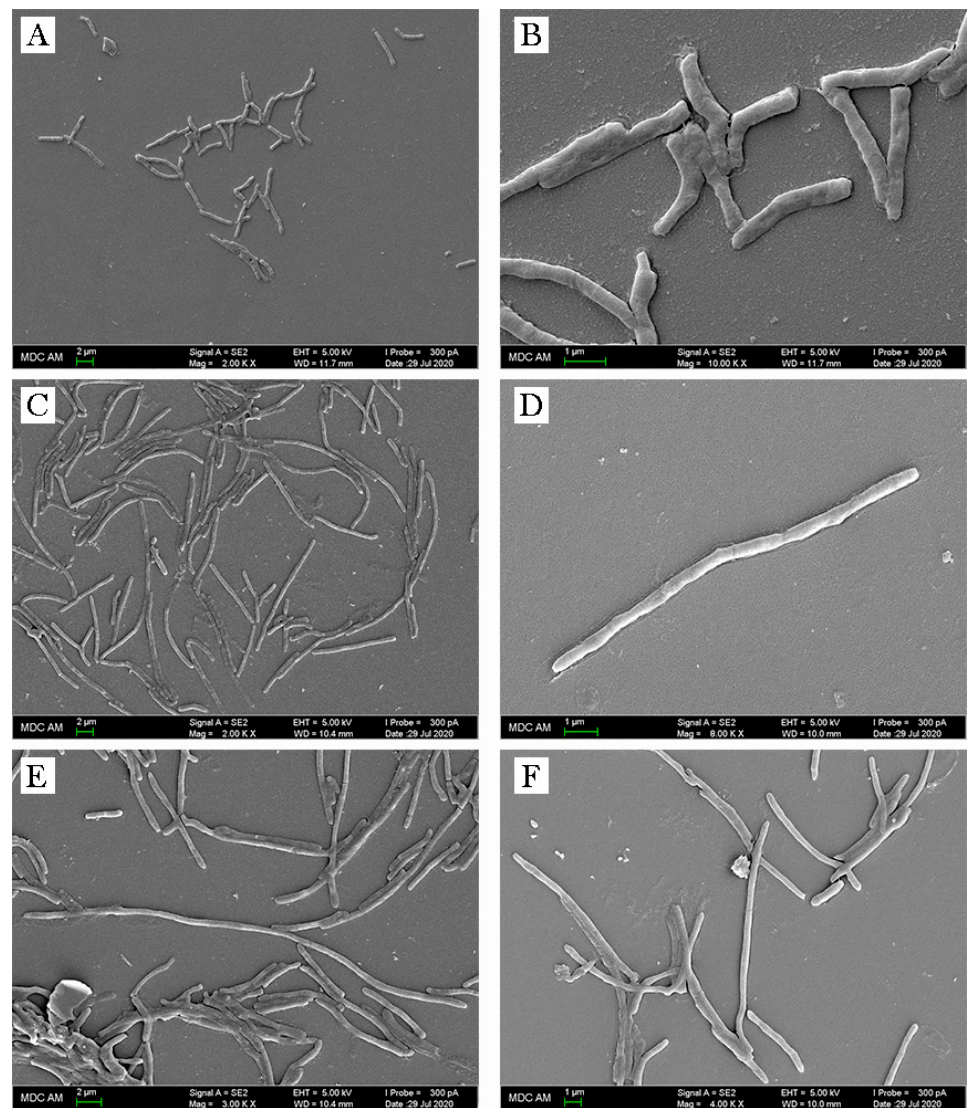
Figure 3. SEM images of M. smegmatis : ( A , B ) control cells; ( C – F ) cells growing with Olivomycin A. Table 1. G4s from the genome of M. smegmatis and their ligand-induced changes.